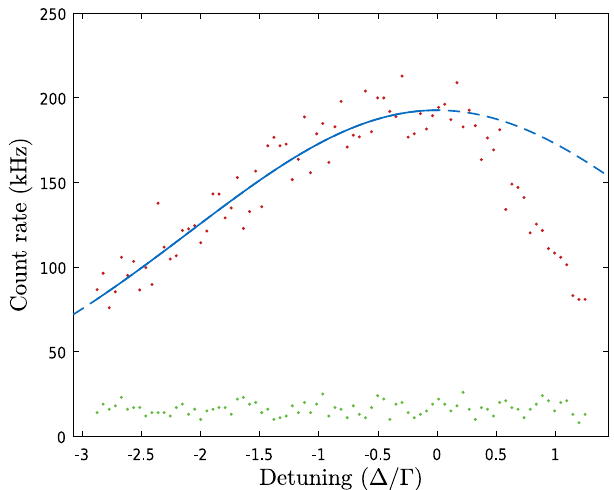
Fig. 10 Fluorescence signal from a pure Be + plasma as the frequency of the cooling laser is scanned across the laser cooling transition. The background-corrected signal (red points) has been fi t with a Voigt function (blue solid line) on the left-hand side of the peak. It is clear that the function fi ts poorly if it is continued onto the right-hand side of the peak (blue dashed line) where the fl uorescence signal drops off rapidly. This sharp decay in signal is attributed to the heating of the ions when the laser detuning is on the blue side of the resonance. The Voigt pro fi le corresponds to an ion temperature of ~150 mK. The background signal on the detector when no ions are loaded, which comes mainly from the scatter of the laser beam within the apparatus, is shown for reference (green means that the right-hand side of the peak is ignored in the analysis. In order to extract a temperature, the Voigt function is deconvolved into its Lorentzian and Gaussian components. From the Gaussian full width at half maximum, the ion temperature can then be calculated. Due to limitations in the AOM frequency range and the small solid angle we cannot currently conduct fl uorescence-based temperature diagnostics of Be + in mixed samples of Be + and e + where the Be + number is much lower and the temperature higher than in the example mea- surement in Fig. 10.